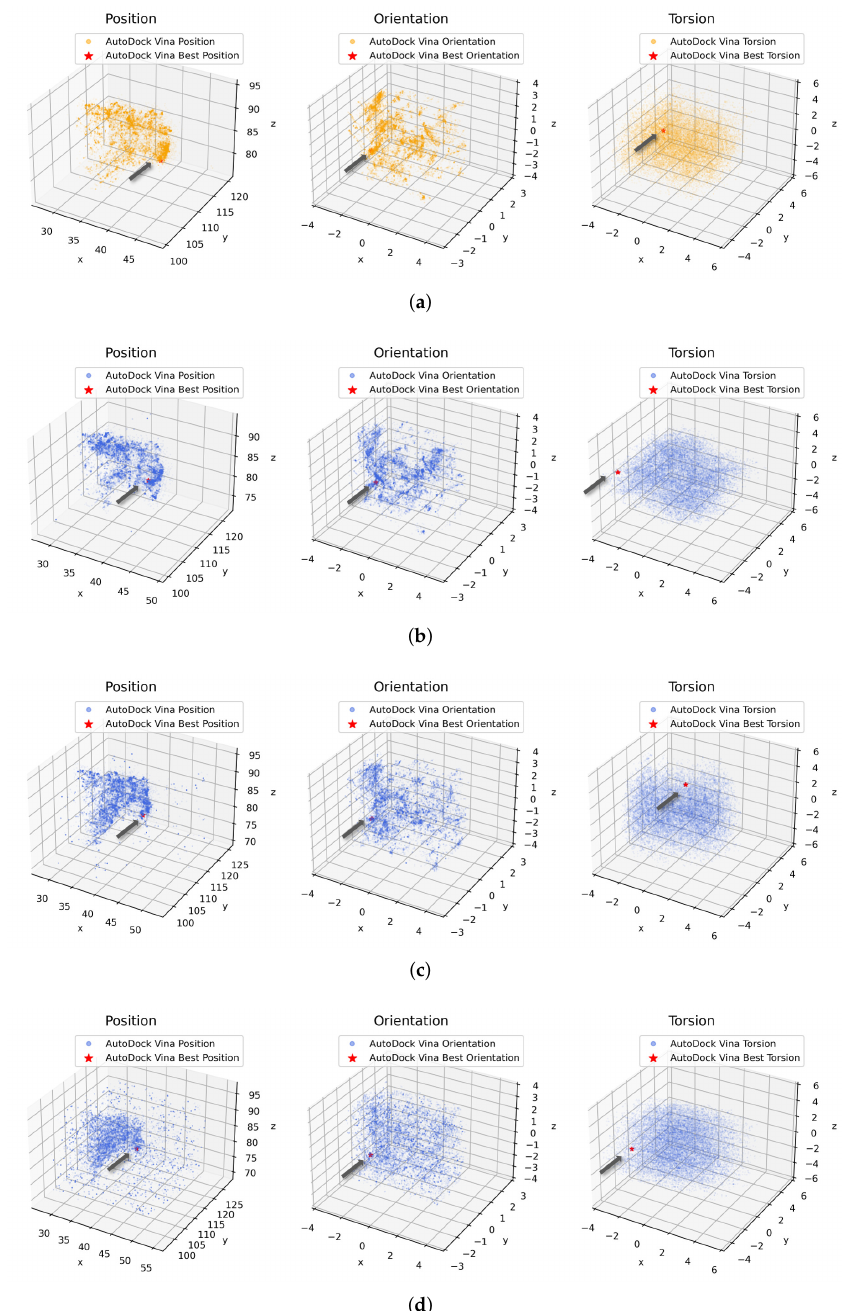
Figure 10. Similar distribution of full conformation spaces (PDBid: 2bm2) explored by AutoDock Vina or our Vina-GPU with various hyperparameter settings. AutoDock Vina ( cpu = 1, exhaustiveness = 1) was executed with one initial conformation and search _ depth = 22,365 by default. Vina-GPU was performed under different scales of docking threads with various search _ depth in each thread. The whole searching iterations (= thread × search _ depth ) keep almost the same. Each conformation is represented by its position, orientation and torsion (POT), all of which are plotted with orange dots in AutoDock Vina and bule dots in Vina-GPU. The principal component analysis (PCA) method was used to reduce the dimensions of orientation or torsion into three. The best conformations for their final output are highlighted with red stars (pointed by arrows). ( a ) AutoDock Vina: 1 initial con- formation with search _ depth = 22,365. ( b ) Vina-GPU: 10 docking threads with search _ depth = 2237. ( c ) Vina-GPU: 100 docking threads with search _ depth = 224. ( d ) Vina-GPU: 1000 docking threads with search _ depth =